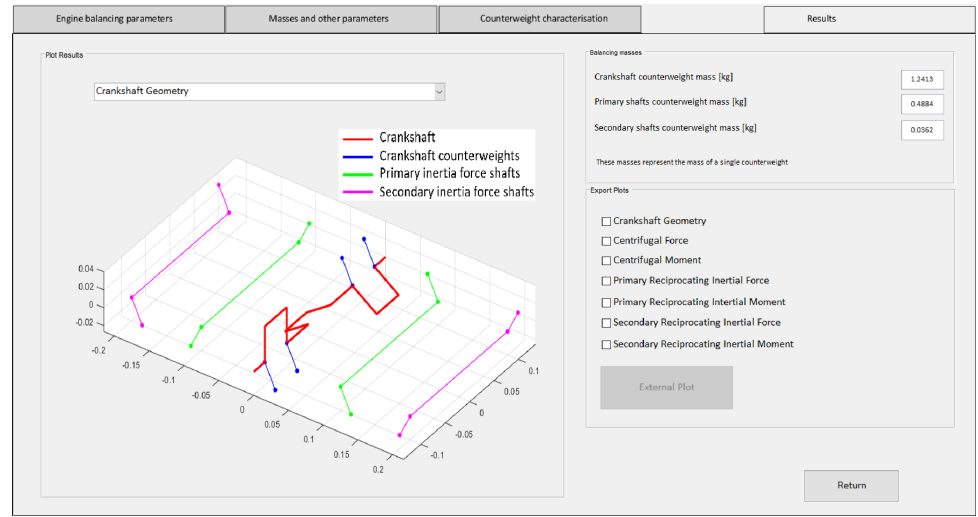
Figure 9. Tab of the user-interface dedicated to the preliminary balancing results.